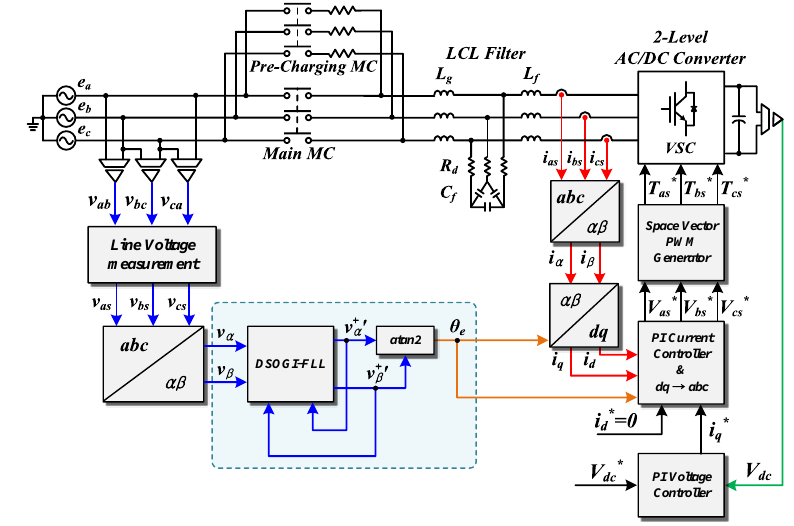
Figure 14. Control block diagram of 3-phase AC/DC PWM converter with SOGI-FLL.